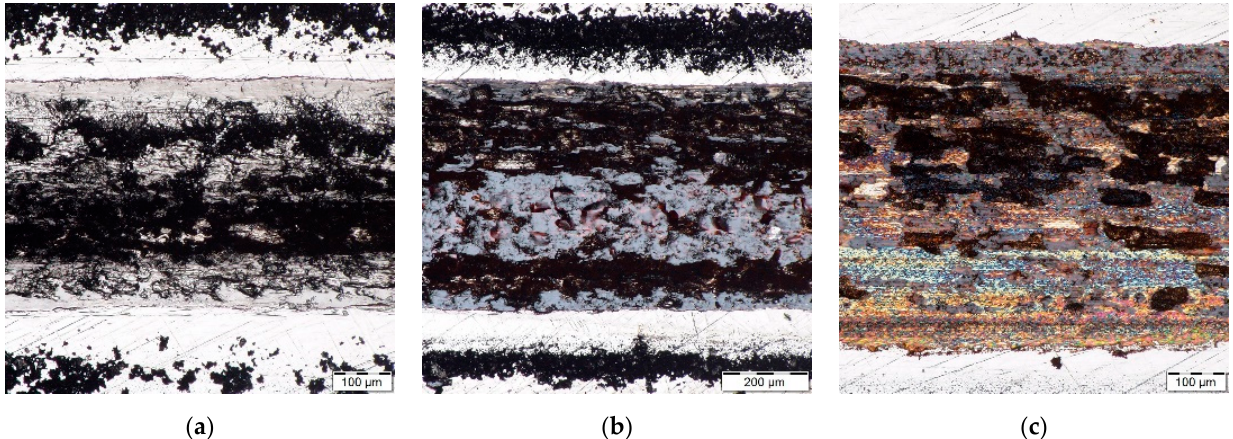
Figure 13. Morphology of the wear tracks on UN material of steel H13 after finishing addition tribological tests at time of: ( a ) 200 s; ( b ) 400 s; ( c ) 1000 s.